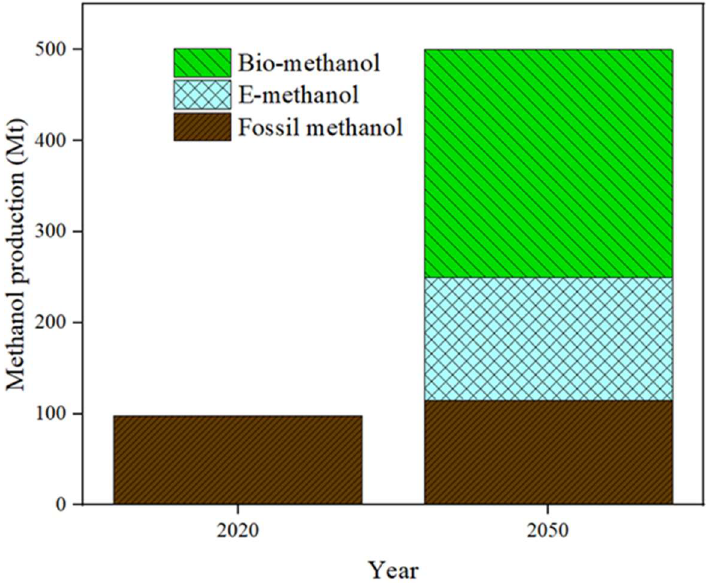
Figure 7. ( a ) Countries by the count of existing renewable methanol projects; ( b ) projected renewable methanol production capacity by start-up year. Based on data from Ref. [46].